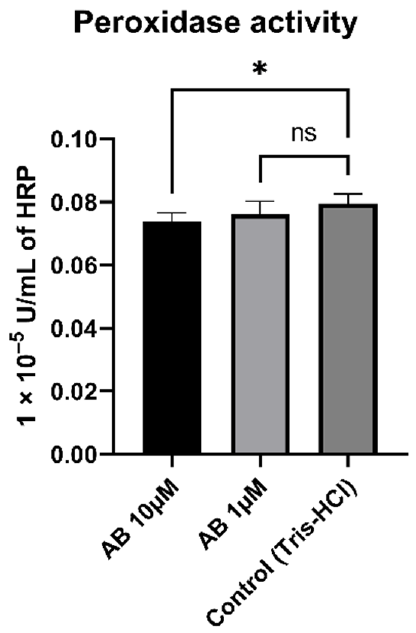
Figure 7. Effect of A β on peroxidase activity in SH-SY5Y-MOCK cells incubated with different concentrations of A β for 24 h. Respective mean values ± SD are shown, N = 7. Significance was determined by one-way ANOVA. * p < 0.05. A β , amyloid beta.